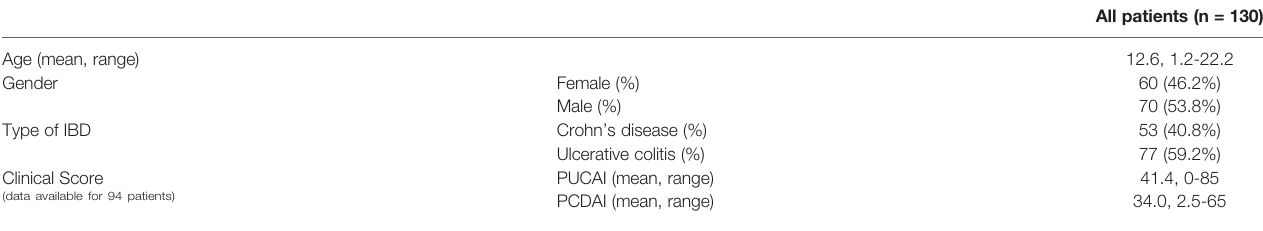
TABLE 1 | Demographic and clinical characteristics of the patients enrolled in the study.